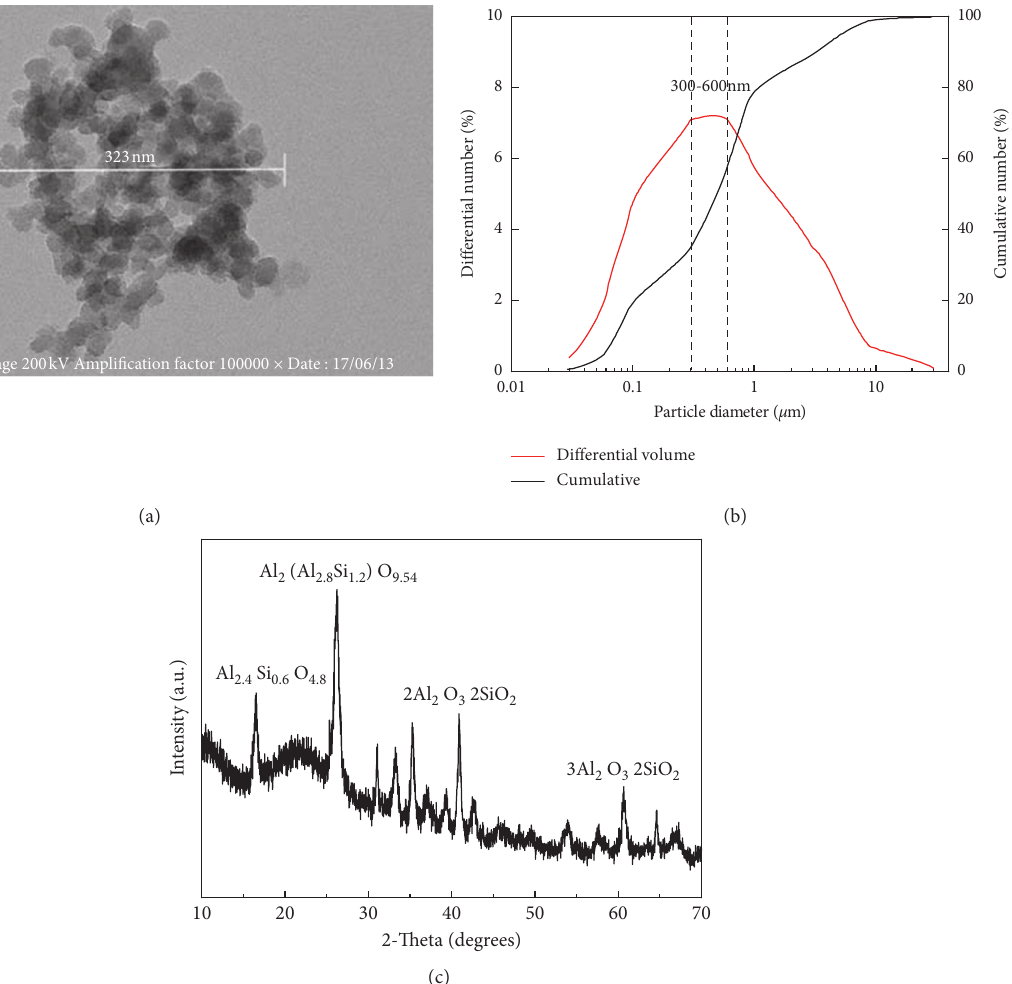
Figure 2: (a) The TEM image of the SMK; (b) particle size distribution of SMK; (c) the XRD pattern of the